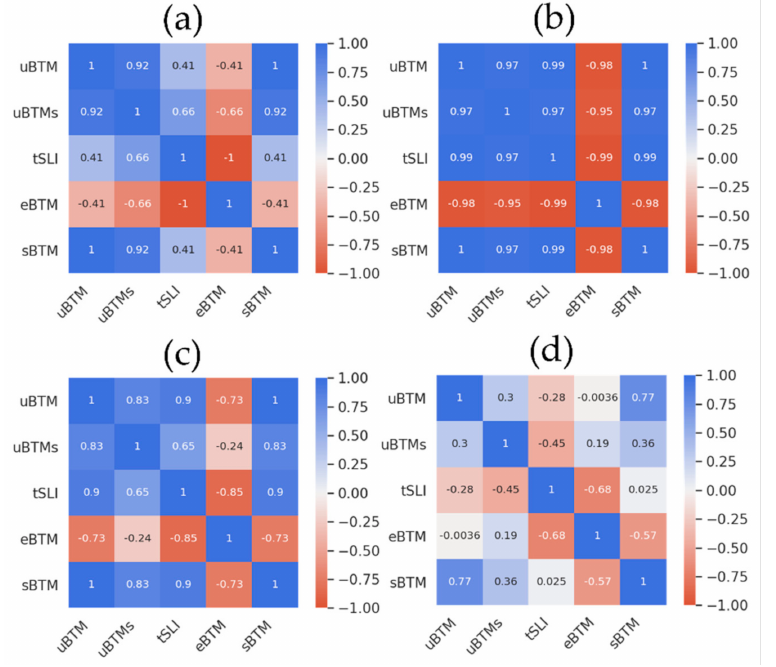
Figure 7. Correlation matrix in RSCP. ( a ) Area differences. ( b ) Kernel Density correlation matrix. ( c ) Deep AI image similarity API. ( d ) Resemble.js image similarity API. The values of correlation are included in the